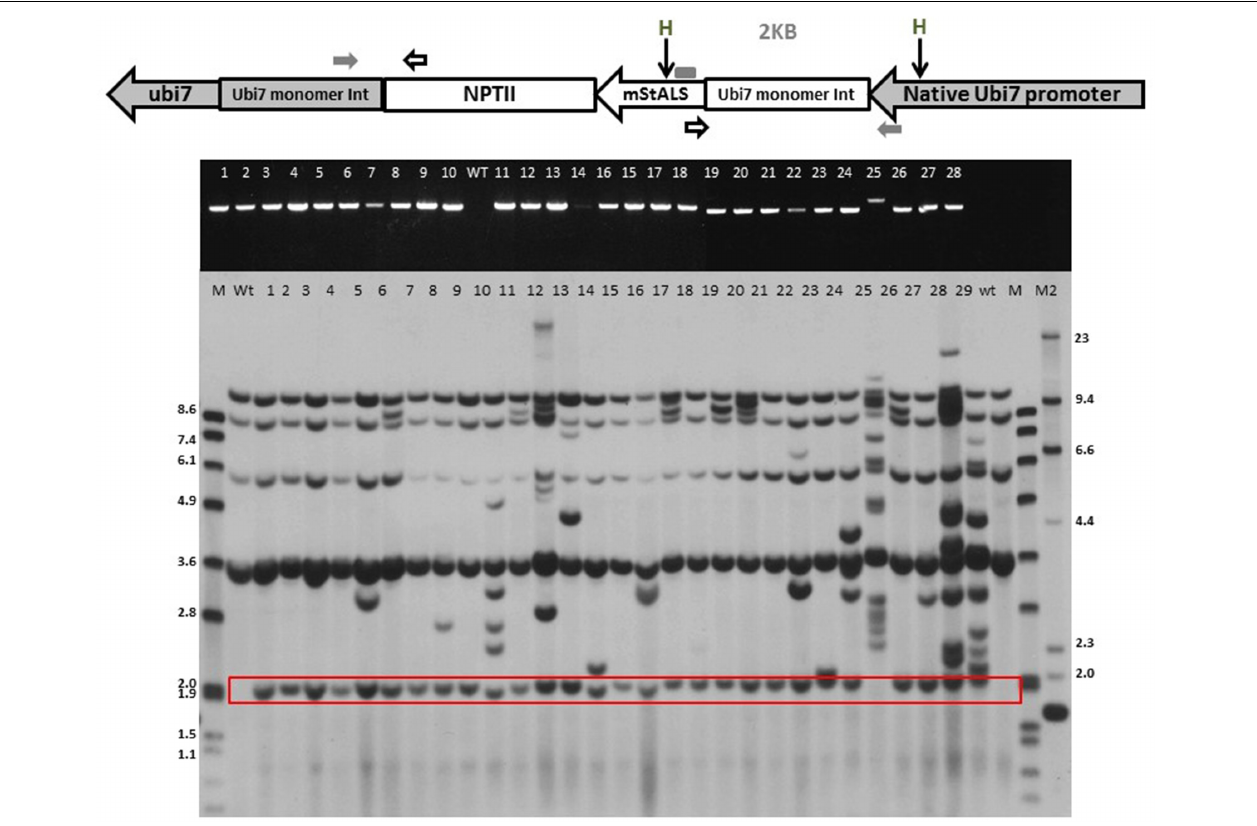
FIGURE 5 | Identification of targeted integration events. DNA from herbicide resistant transgenic lines were isolated for PCR and Southern analyses. (Top panel) Schematic of the Ubi7 locus after site-specific gene integration. Primers 1: within the endogenous Ubi7 promoter and 2: within the mStALS gene coding region are indicated by arrows. Two HindIII restriction enzyme sites, one in the endogenous Ubi7 promoter and one in the mStALS coding region are also labeled. (Middle panel) : PCR using primers 1 and 2 detects site-specific integration events. (Bottom panel) : Southern blot using StALS probe detects the site-specific integration band at predicted size (boxed). The size of dig-labeled ladders were marked as kb (M: Dig-labeled marker 7, M2: Dig-labeled marker